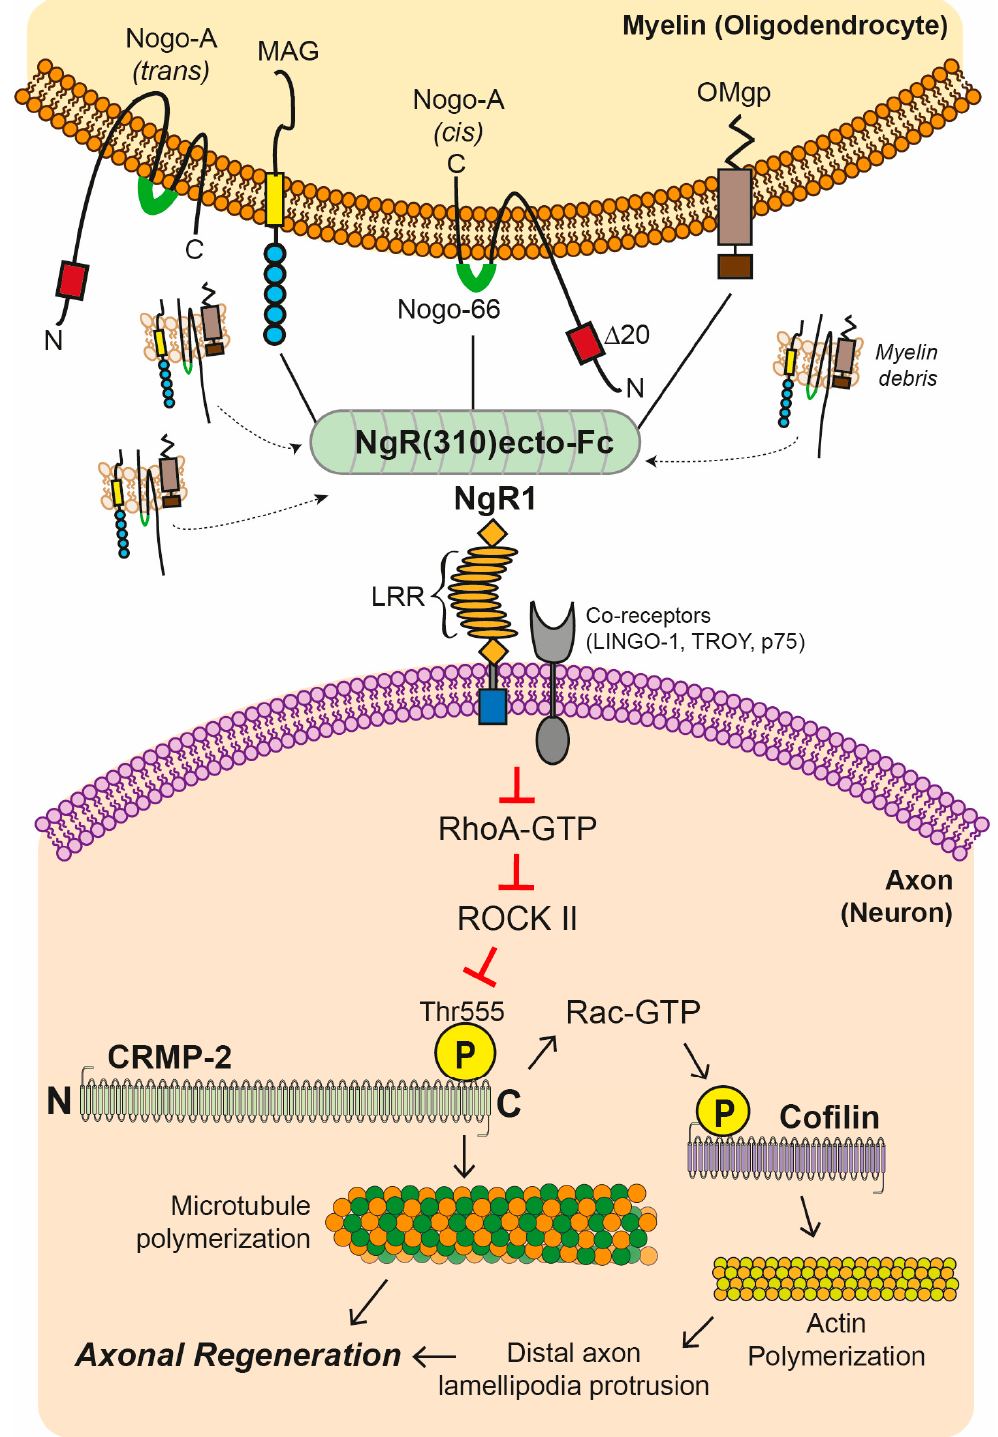
Figure 3. Blockade of Nogo receptor 1 (NgR1)-dependent signaling cascade with NgR(310)ecto-Fc fusion protein.